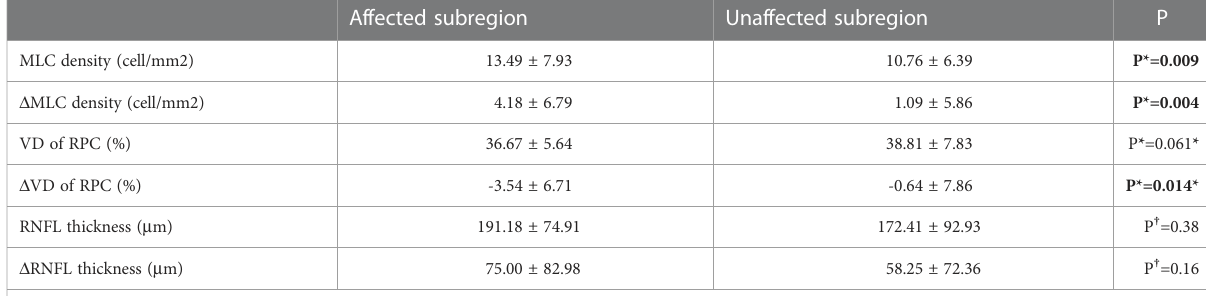
TABLE 3 Results of MLC density, VD of RPC and RNFL thickness in sectorial